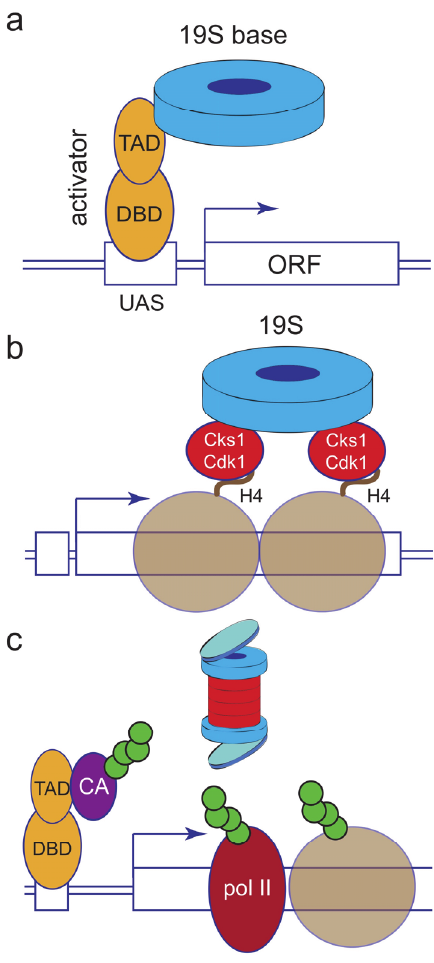
Figure 2. Models for recruitment of proteasome subunits to chromatin. ( a ) Recruitment by direct contact with activators. A model activator, with its separable DNA-binding domain (DBD) and transcriptional activation domain (TAD) is shown bound to an upstream